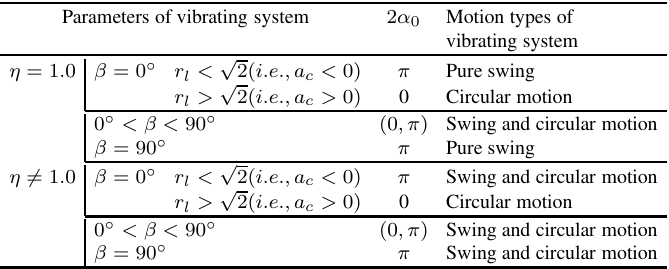
Fig. 4. The values of a c for β and r l .